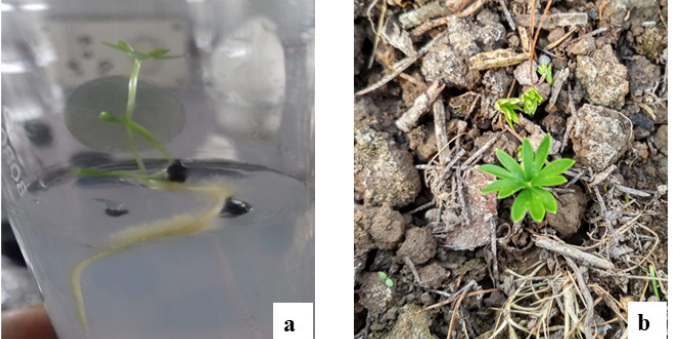
Figure 1. Seed germination in Aconitum chasmanthum Stapf ex Holmes: ( a ) seed germination in MS basal medium; ( b ) seed germination in garden soil. Table 2. Effect of different plant growth regulators (PGRs) on direct shoot induction, shoot length (mean ± SEM), shoot number (mean ± SEM) and percentage response (mean ± SEM) from the nodal explants. PGR (mg/L) Response Time (Days, Percentage Response Shoot Length (cm, Shoot Number (Mean ± SEM)BAP 2,4-D Mean ± SEM) Mean ± SEM) (Mean ± SEM)